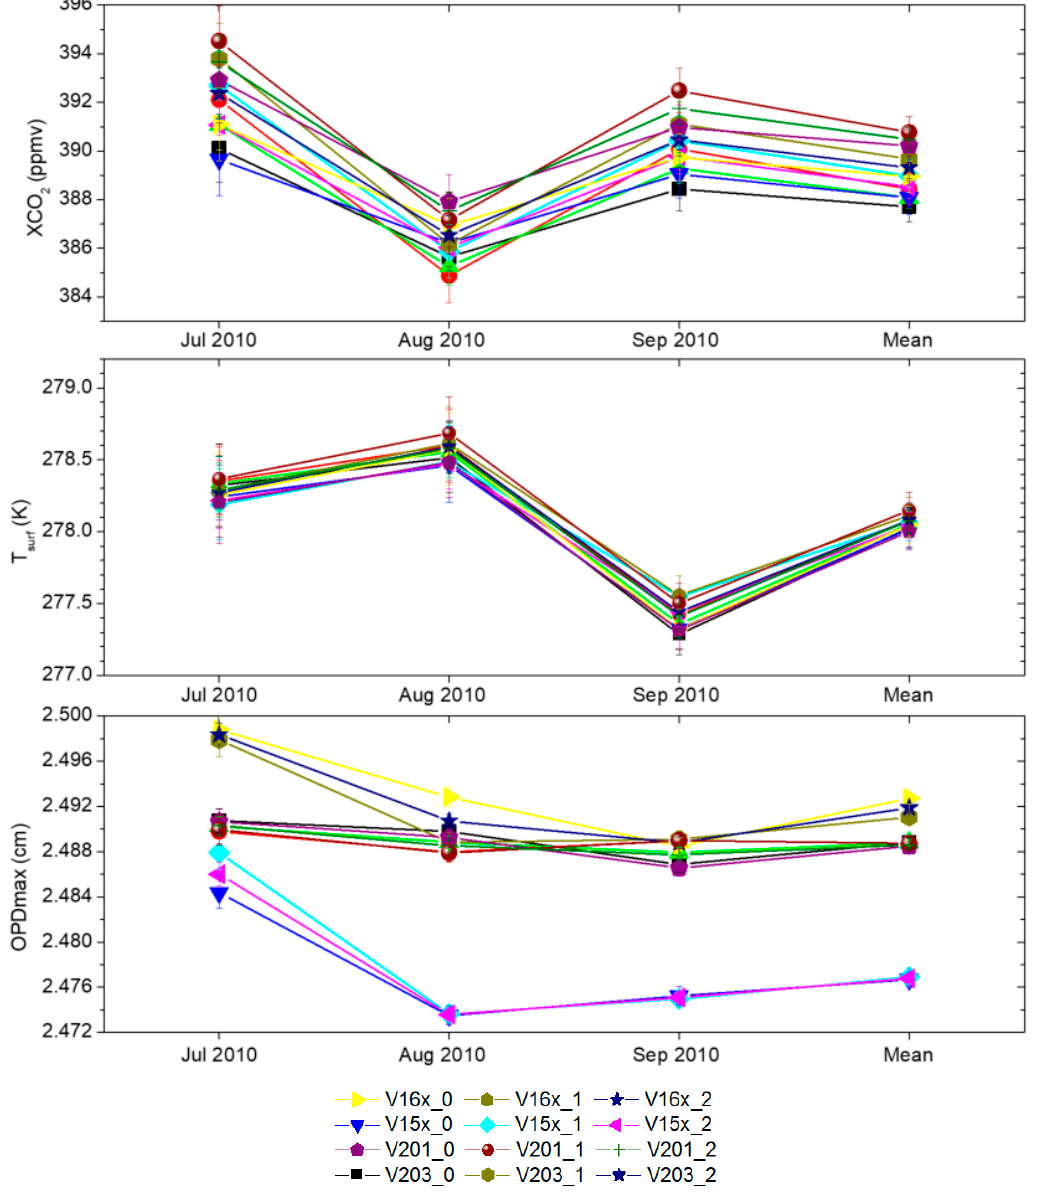
Figure 7. XCO 2 for summer 2010, T surf for summer 2010, OPD max for summer 2010, for each version (V203, V15x, V16x, V201) as a function of year/month and OPD direction (0 = forward, 1 = backward, 2 = both). The differences between the forward and backward directions is not significant. However, there are differences of the monthly mean of OPD max for V16x and V15x that are not seen in V201 and V203. These last two versions then seem more reliable.